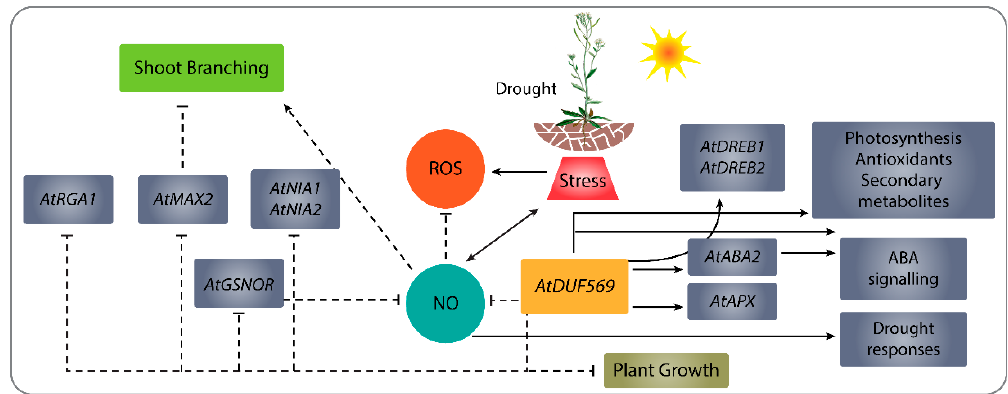
Figure 10. A simple schematic illustration of a proposed function of DUF569 in Arabidopsis thaliana during drought stress.